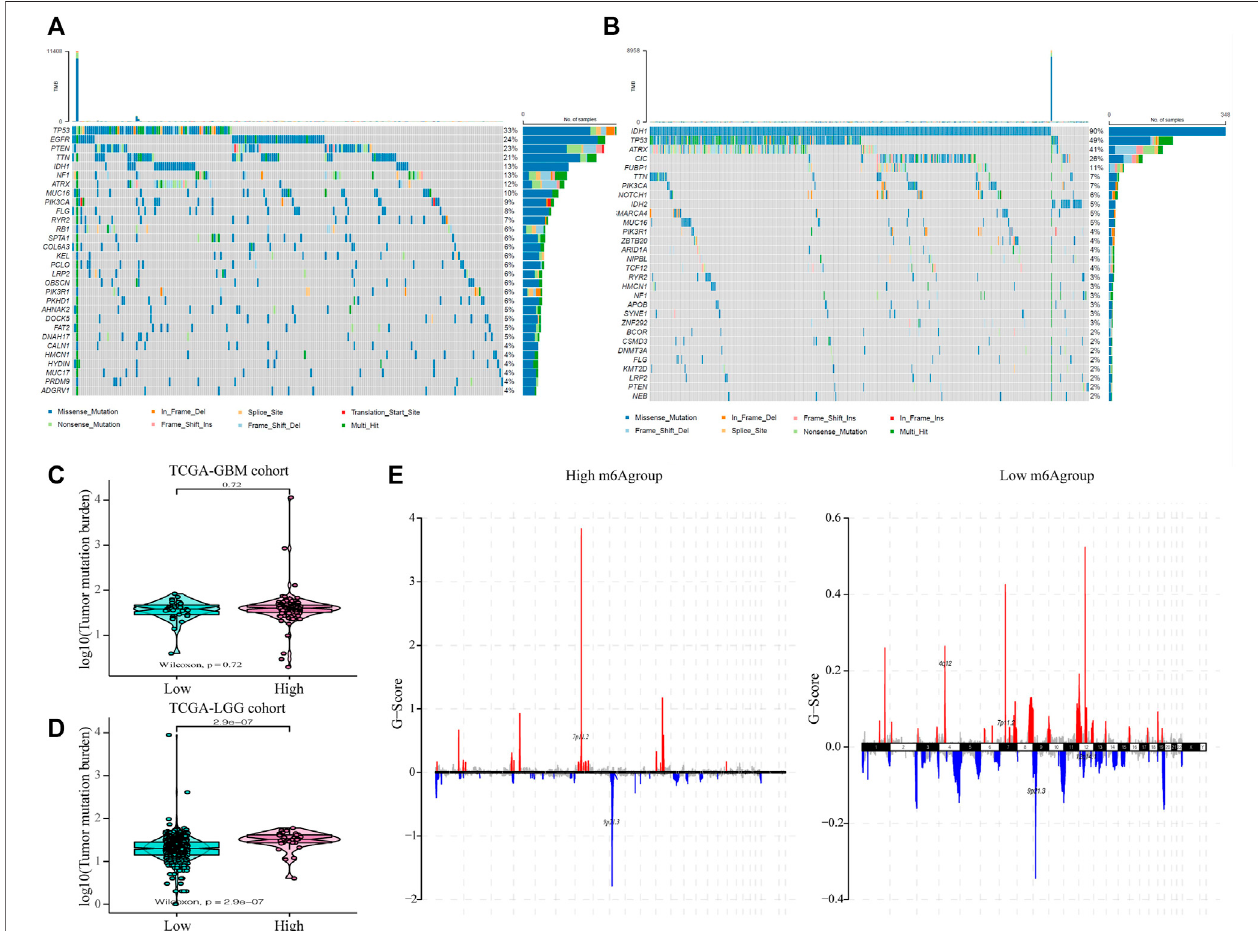
FIGURE6| Thein fl uenceofdifferentm6AriskgroupsonthegeneticvariationofGLIOMApatients. (A – B) Mutationmapsofcommontumorigenesisdrivergenesin glioblastoma multiforme (GBM) and lower-grade glioma (LGG) patients grouped by high and low m6A groups. The mutation information of each gene in each sample is displayed in the waterfall chart with the total percentage of mutation, and various colors indicate different mutation types; the upper section of the legend shows the mutationload; (C) Comparedwiththepatientsinthelowm6Agroup,therewasnosigni fi cantdifferenceinthetumormutationlevelinGBMpatientsinthehighm6A group ( p = 0.72); (D) Compared with patients in the low m6A group, the tumor mutation level in LGG patients in the high m6A group was signi fi cantly higher ( p < 0.001); (E) thecopynumbervariationofgliomapatientsinthehighandlowm6Agroupswasdifferent:red indicates anincreasedcopynumber, while blueindicatesasigni fi cant loss in copy